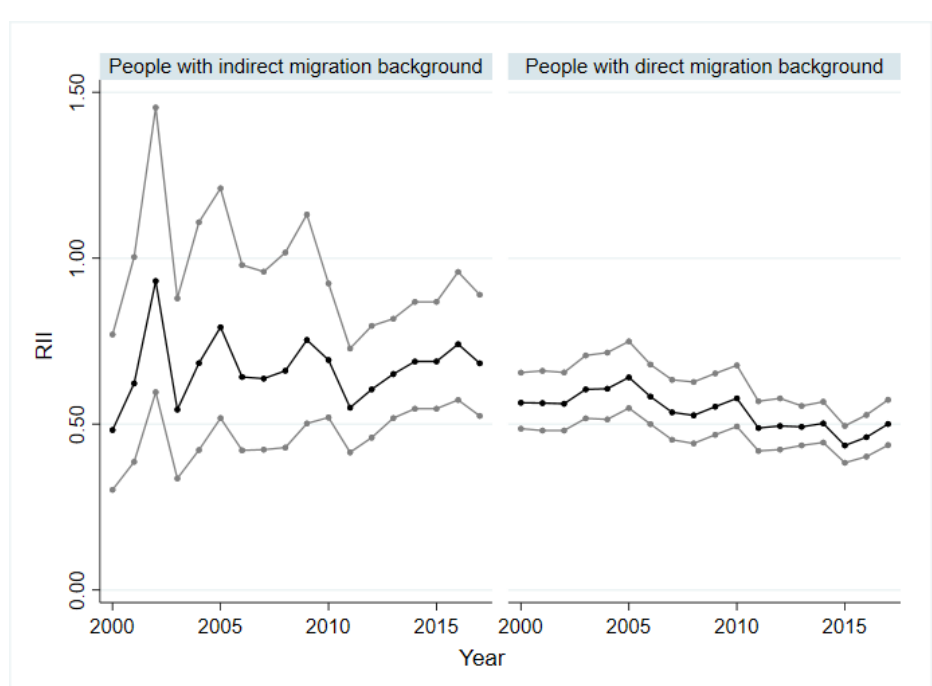
Figure 3. Absolute socio-economic inequalities in SRH in people with direct and indirect migration background, 2000–2017. SRH: self-rated health; SII: slope index of inequality; black line: regression coefficient; grey line: 95% confidence interval.